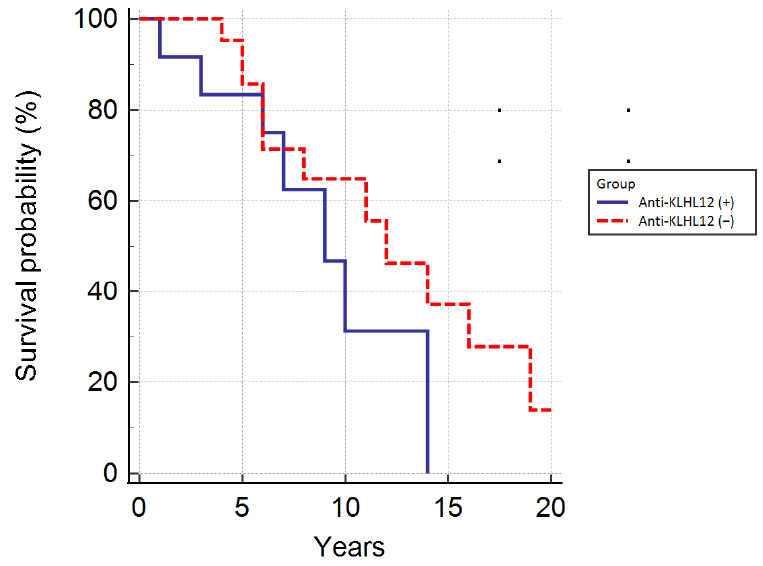
Figure 9. Kaplan–Meier curves demonstrating the survival of patients positive and negative for the anti-KLHL12 antibodies.